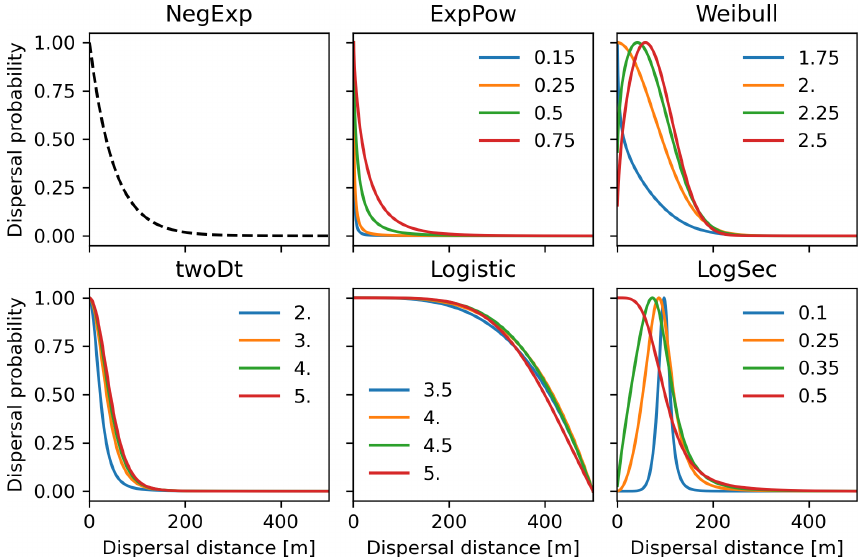
Figure 3. Probability density functions for the newly implemented fat-tailed seed kernels. Fat-tailed kernels with examples of shape parameter values are compared to the default negative exponential (NegExp). Newly implemented kernels are as follows: ExpPow: exponential power; Weibull; twoDt: bivariate Student’s t ; logistic; LogSec: log-hyperbolic secant. See Table 3 for the kernel formulae and range values of the shape parameter for each kernel. Kernel formulae are implemented as PDFs in Eq. (A3) for both the SDD and LDD component. The 2D dispersal patch size (maximum dispersal distance) is 500m (which corresponds to seeds dispersing from the centres of 1km 2 cells as in the default spatial configuration of LPJ-GM), with SDD d and LDD d set to 100 and 500m, respectively. Dispersal probabilities of each kernel are scaled in the [0–1] range for